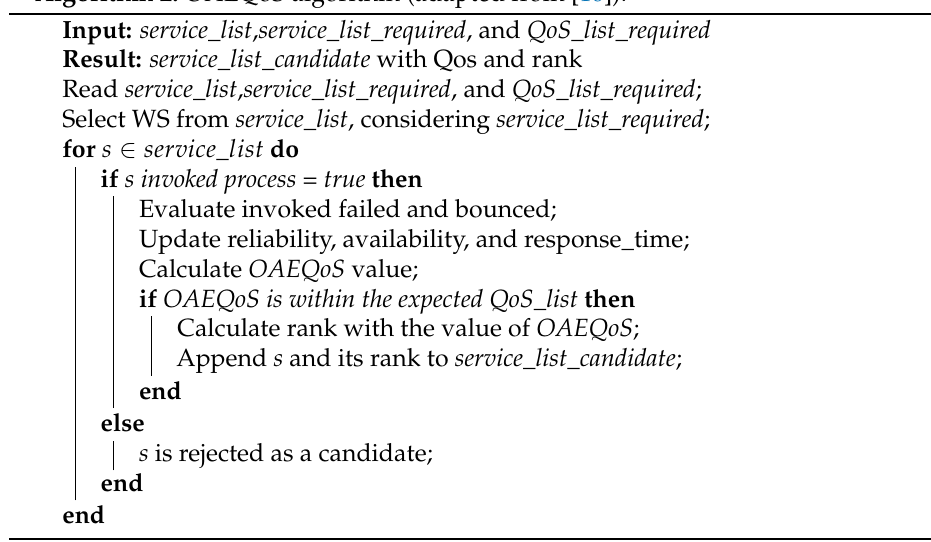
Algorithm 2: OAEQoS algorithm (adapted from